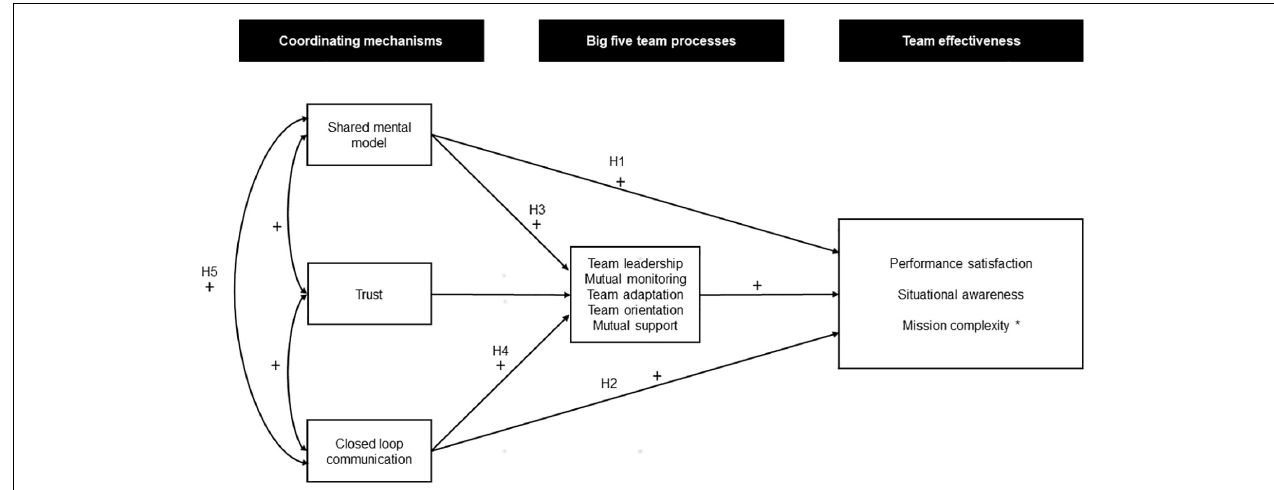
FIGURE 1 | The proposed model of the study. The model is separated for the three coordinating mechanisms of trust, shared mental model and closed loop communication. The Big five team processes are expressed as a composite score of team leadership, mutual monitoring, team adaptation, team orientation and mutual support. Team effectiveness is represented by EMCC operator’s evaluation of performance satisfaction, situational awareness and mission complexity. The predicted directions of the associations are marked on the arrows ( ∗ Negative association between team processes and measure of team